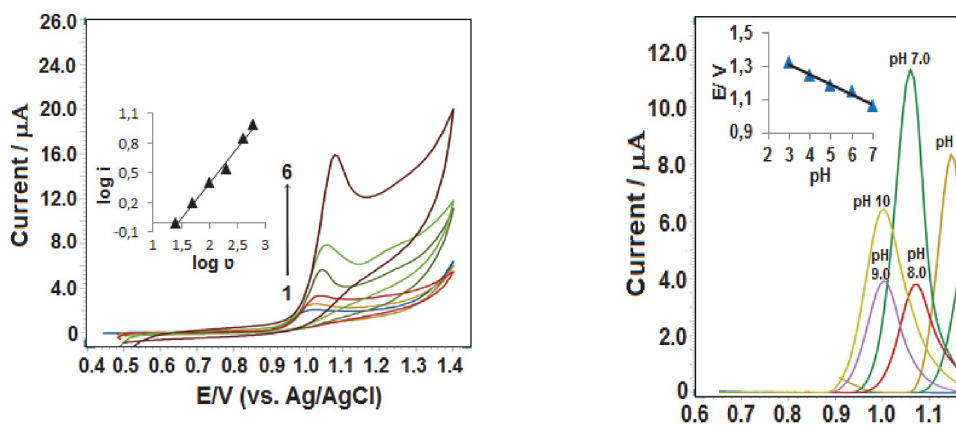
Figure 4. The cyclic voltammograms of 2.4 × 10 –5 M pantoprazole in BR buffer, pH 7.0 at different scan rates (1 –6 : 25, 50, 100, 200, 400, 600 mV s –1 ). Electrode, PGE. Inset depicts the plot of log ip vs. log v. Figure 5. The stripping voltammograms of 2.4 × 10 –6 M pantopra-